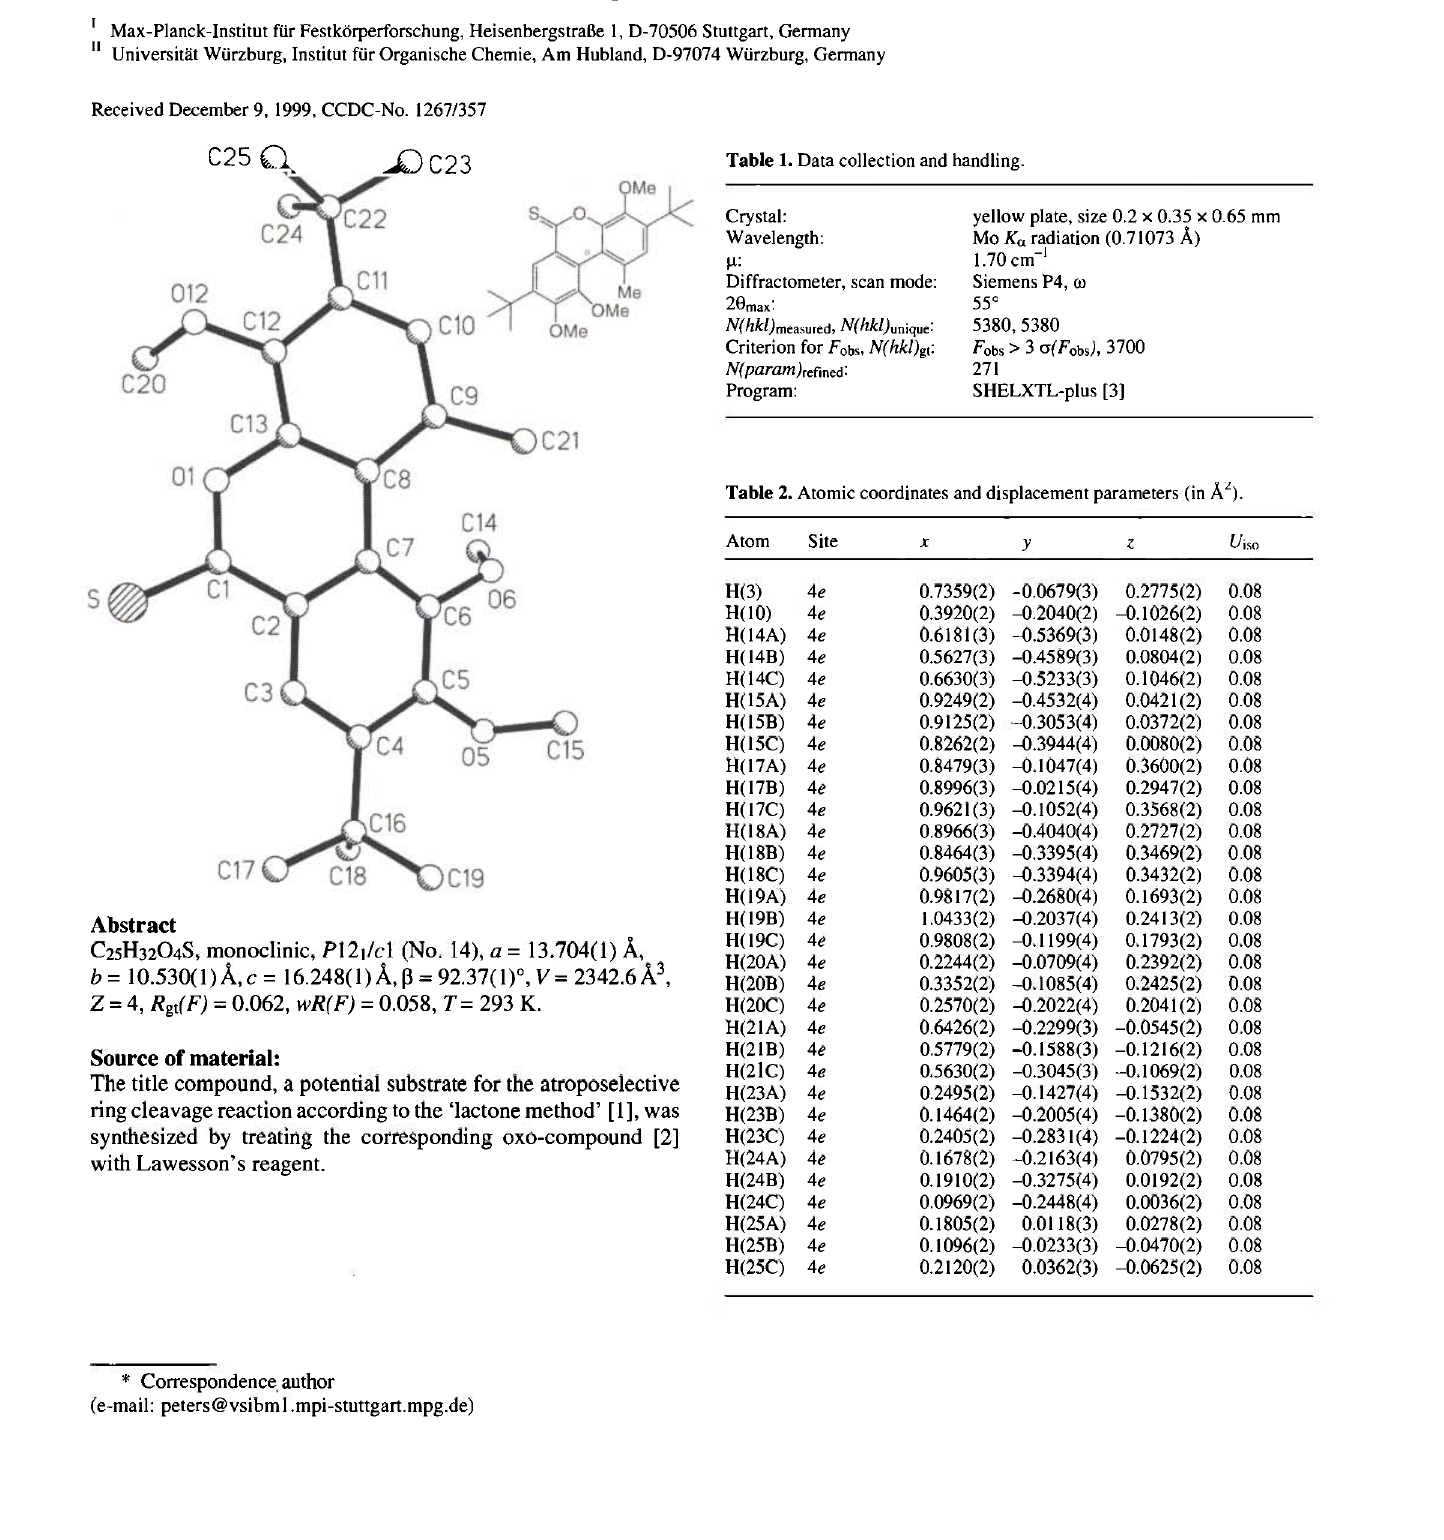
Table 1. Data collection and handling.